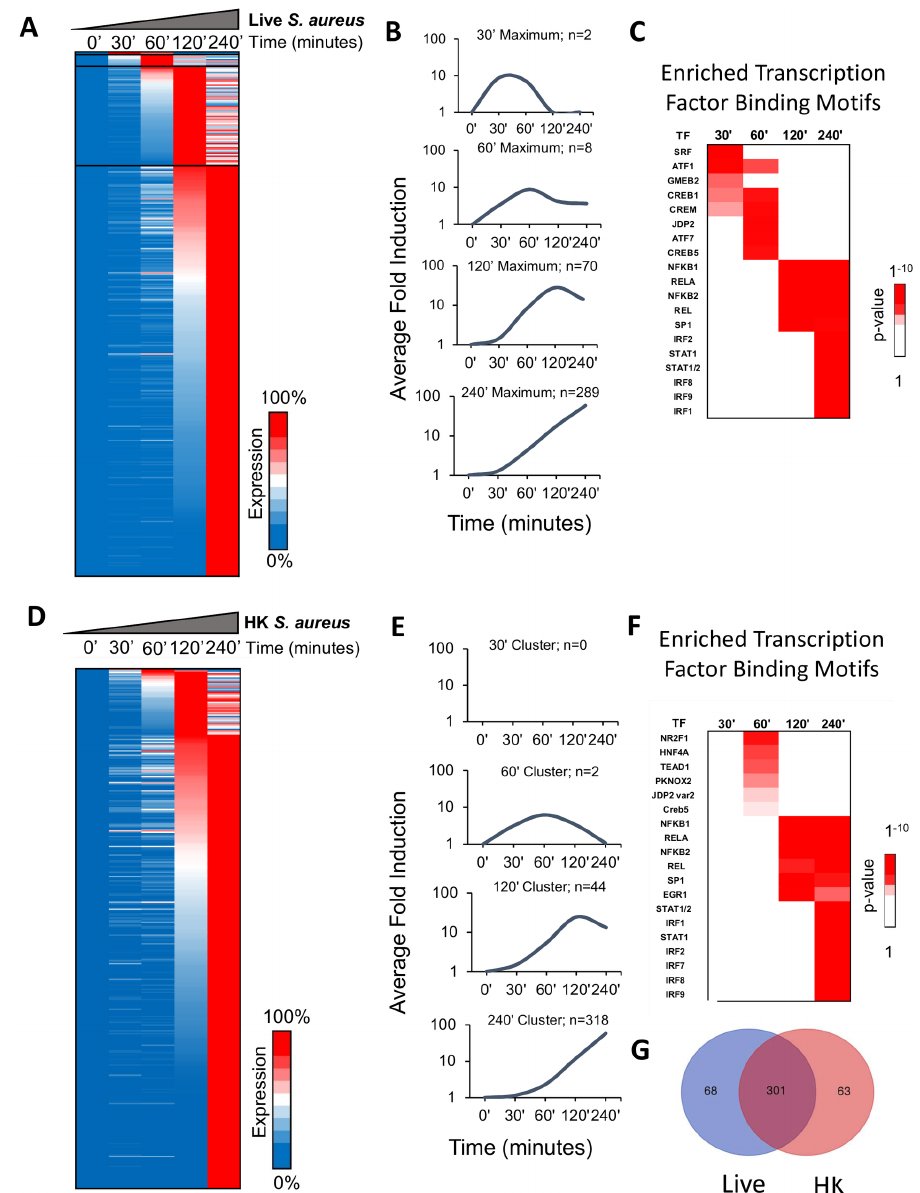
Fig 1. Kinetic properties of the transcriptional cascade to live and HK S . aureus . (A) Activation kinetics are shown for induciblegenesfrom BMDMs stimulatedwith an MOI of 10 of S . aureus at indicatedtime points. Shadesof blue to red indicate percentile values from low to high expression. Shownare all genesmeeting RPKM > 1, Fold change > 5, and p < 0.05by DESeq. The averageof at least 4 separateexperiments is shown for each time point (B) The averagefold of transcript levels of inducible genes separated within representative clusters by time point the genes reach their maximal expressionlevel are shown. (C) Known, highly significant Jaspar 2016 motif enrichment of genes which reach maximal expressionlevels at the indicatedtime points following S . aureus infection. (D) Activation kinetics are shown for inducible genes from BMDMs stimulated with the equivalent of an MOI of 10 HK S . aureus at indicatedtime points. Shadesof blue to red indicate percentile values from low to high expression. Inductionand expressioncriteria are as in A. Shownare all genesmeeting RPKM > 1, Fold change > 5, and p < 0.05by DESeq. The averageof at least 2 separate experiments is shown for each time point (E) The averagefold of transcript levels of induciblegenes separated within representative clusters by time point the genes reach their maximal expressionlevel are shown. (F) Known, highly significantJaspar 2016 motif enrichment of genes which reach maximal expression levels at the indicatedtime points following S . aureus infection. (G) Venn diagramshowingdegreeof